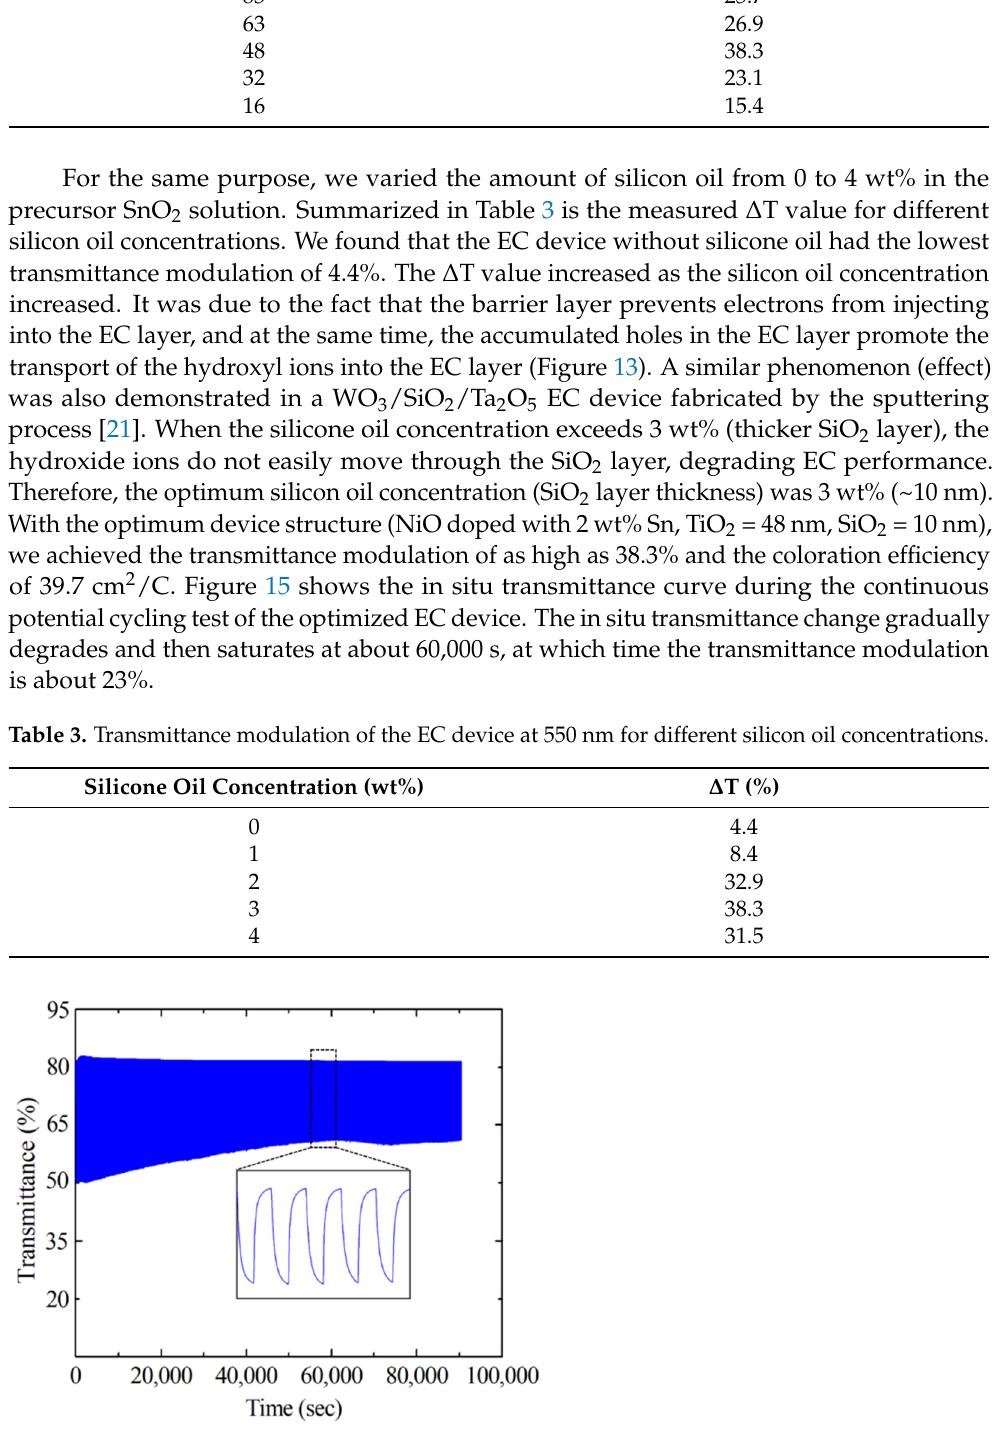
Figure 15. In situ transmittance curve during the continuous potential cycling test of the optimized EC device (NiO doped with 2 wt% Sn, TiO 2 = 48 nm, SiO 2 = 10